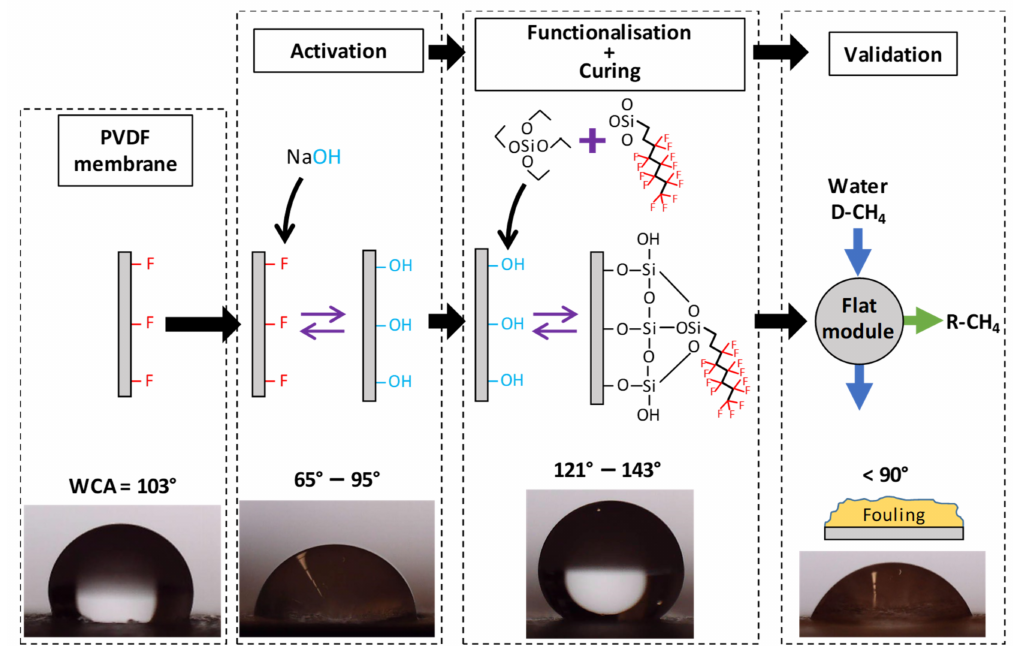
Figure 1. Scheme of the modification procedure of poly(vinylidene fluoride) (PVDF) membranes and the validation step. Water contact angle (WCA): static water contact angle; D-CH 4 : methane dissolved in liquid streams; R-CH 4 : methane recovered in gaseous